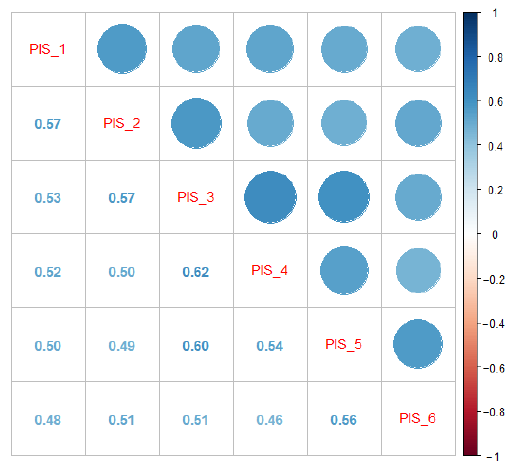
Figure 4. Correlation matrix plot of PIS items.